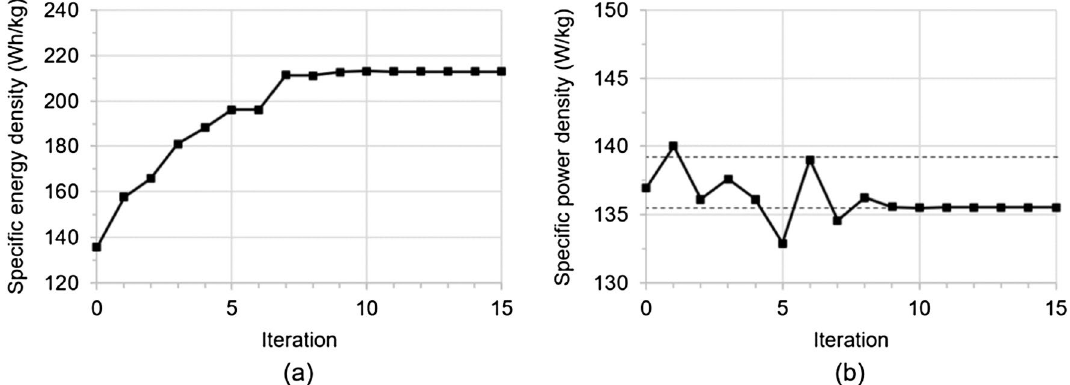
Figure 6. Convergence history of optimization of ( a ) objective function: the specific energy density and ( b ) constraints: the specific power density.